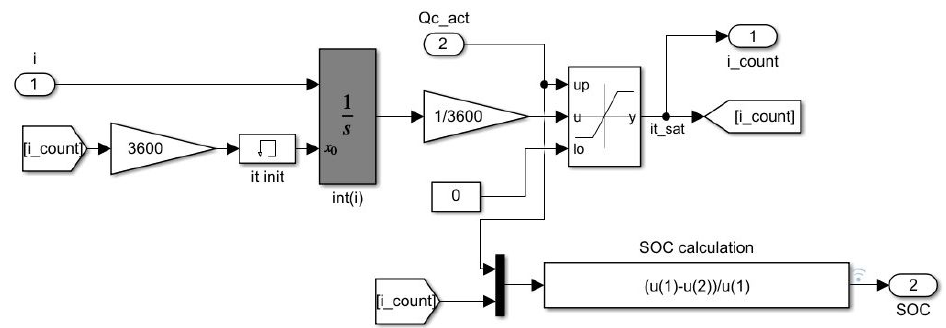
Figure 18. Coulomb counting and SoC evaluation. Where Q_act parameter computing is based on the equation described below in the Actual capacity calculation block section, i is the actual sensed